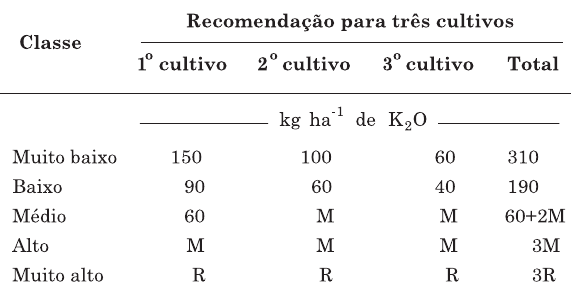
Figura 3. Teor de K extraído por Mehlich-1 em três épocas, teor inicial, equações de resposta do solo à aplicação de K na sucessão trigo/soja/trigo no experimento